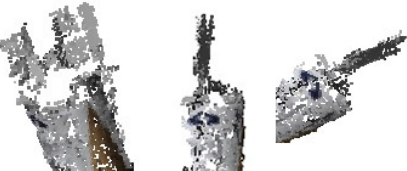
Figure 10. Incorrect reconstruction caused by the erasure of the supporter and turntable.